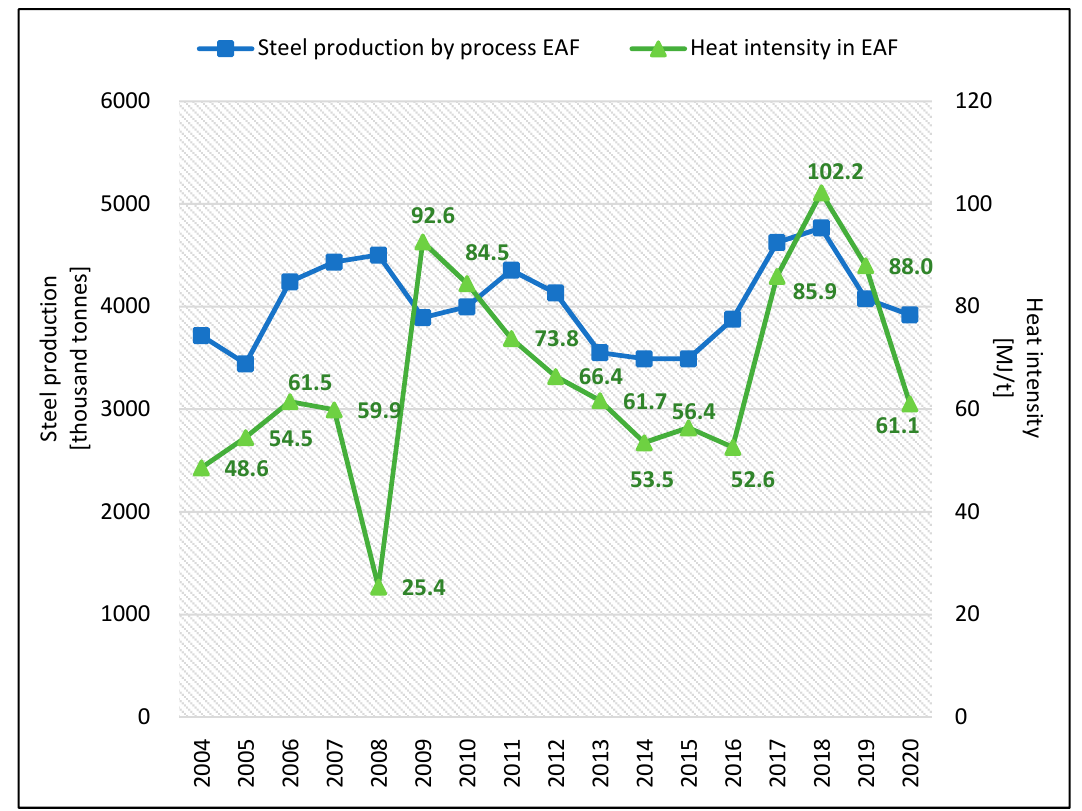
Figure 2. Heat intensity per 1 tonne of steel in the EAF process in Poland from 2004 to 2020. Source: Own elaboration based on data from [11].